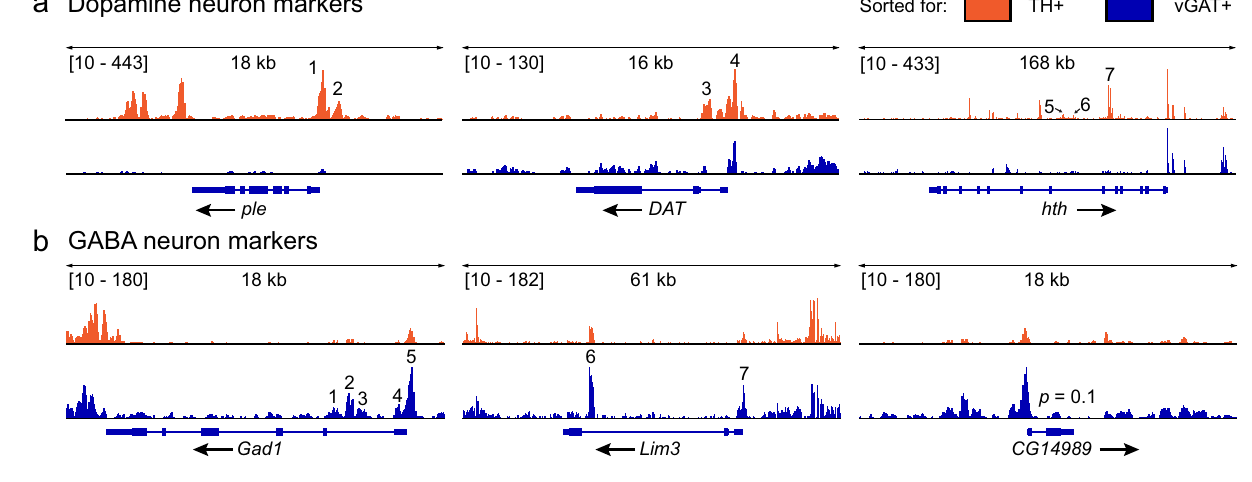
Figure 7. Optimized ATAC-seq libraries return expected cellular markers. ATAC-seq peaks in marker genes for dopaminergic and GABAergic neurons. ATAC-seq reads from dopamine neurons (tyrosine hydroxylase: TH+) are shown in orange and reads from GABA (vesicular GABA transporter: vGAT+) neurons are shown in blue. The genes and gene structures are shown below the ATAC-seq peaks. ( a ) Peaks in chromatin regions that are more open in dopamine neurons. ple (encoding tyrosine hydroxylase; p = 2.43e−68) and DAT (dopamine transporter; p = 9.64e−7) are classical dopamine neuron markers. hth (homothorax; p = 1.16e−52) is a recently described dopamine neuron marker. ple : p = 3.32e−65 (1) and 5.01e−53 (2); DAT : p = 1.03e−05 (3) and 1.04e−05 (4); hth : p = 0.009 (5), 1.69e−36 (6), and 1.14e−21 (7). ( b ) Chromatin regions that are more open in GABA neurons. Gad1 (glutamic acid decarboxylase 1; p = 6.64e−8) is a classical GABAergic neuron marker, while Lim3 (Lim3; p < 0.0002) and CG14989 (uncharacterized protein; p = 0.1) are additional GABA neuron markers. Gad1 : p = 0.0005 (1), 4.42e−08 (2), 0.04 (3), 0.01 (4), and 6.6e−08 (5); Lim3 : p = 1.39e−05 (6) and 0.001 (7). CG14989 , Lim3 , and hth were described as specific markers using single-cell RNA sequencing 41 . The boxes in the gene structures indicate exons and the arrows indicate the transcription